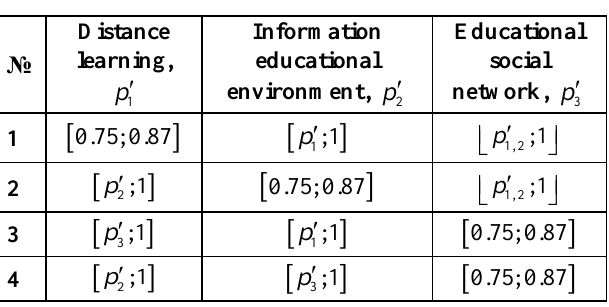
Table 13 – Variants of values for particular characteristics